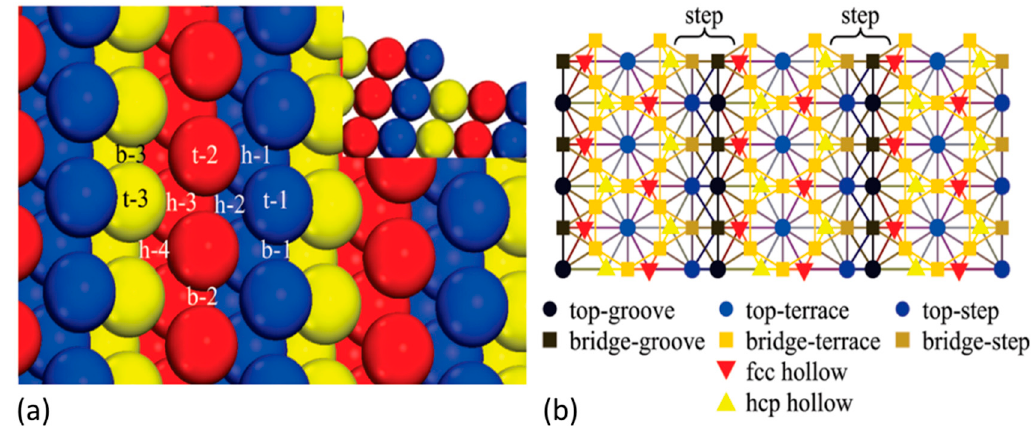
Figure 22. ( a ) Model of the Pt(211) surface used in the DFT calculations. ( b ) Lattice for the Pt(211) used in the KMC simulations, adapted from [152], with permission from American Chemical Society, 2011.